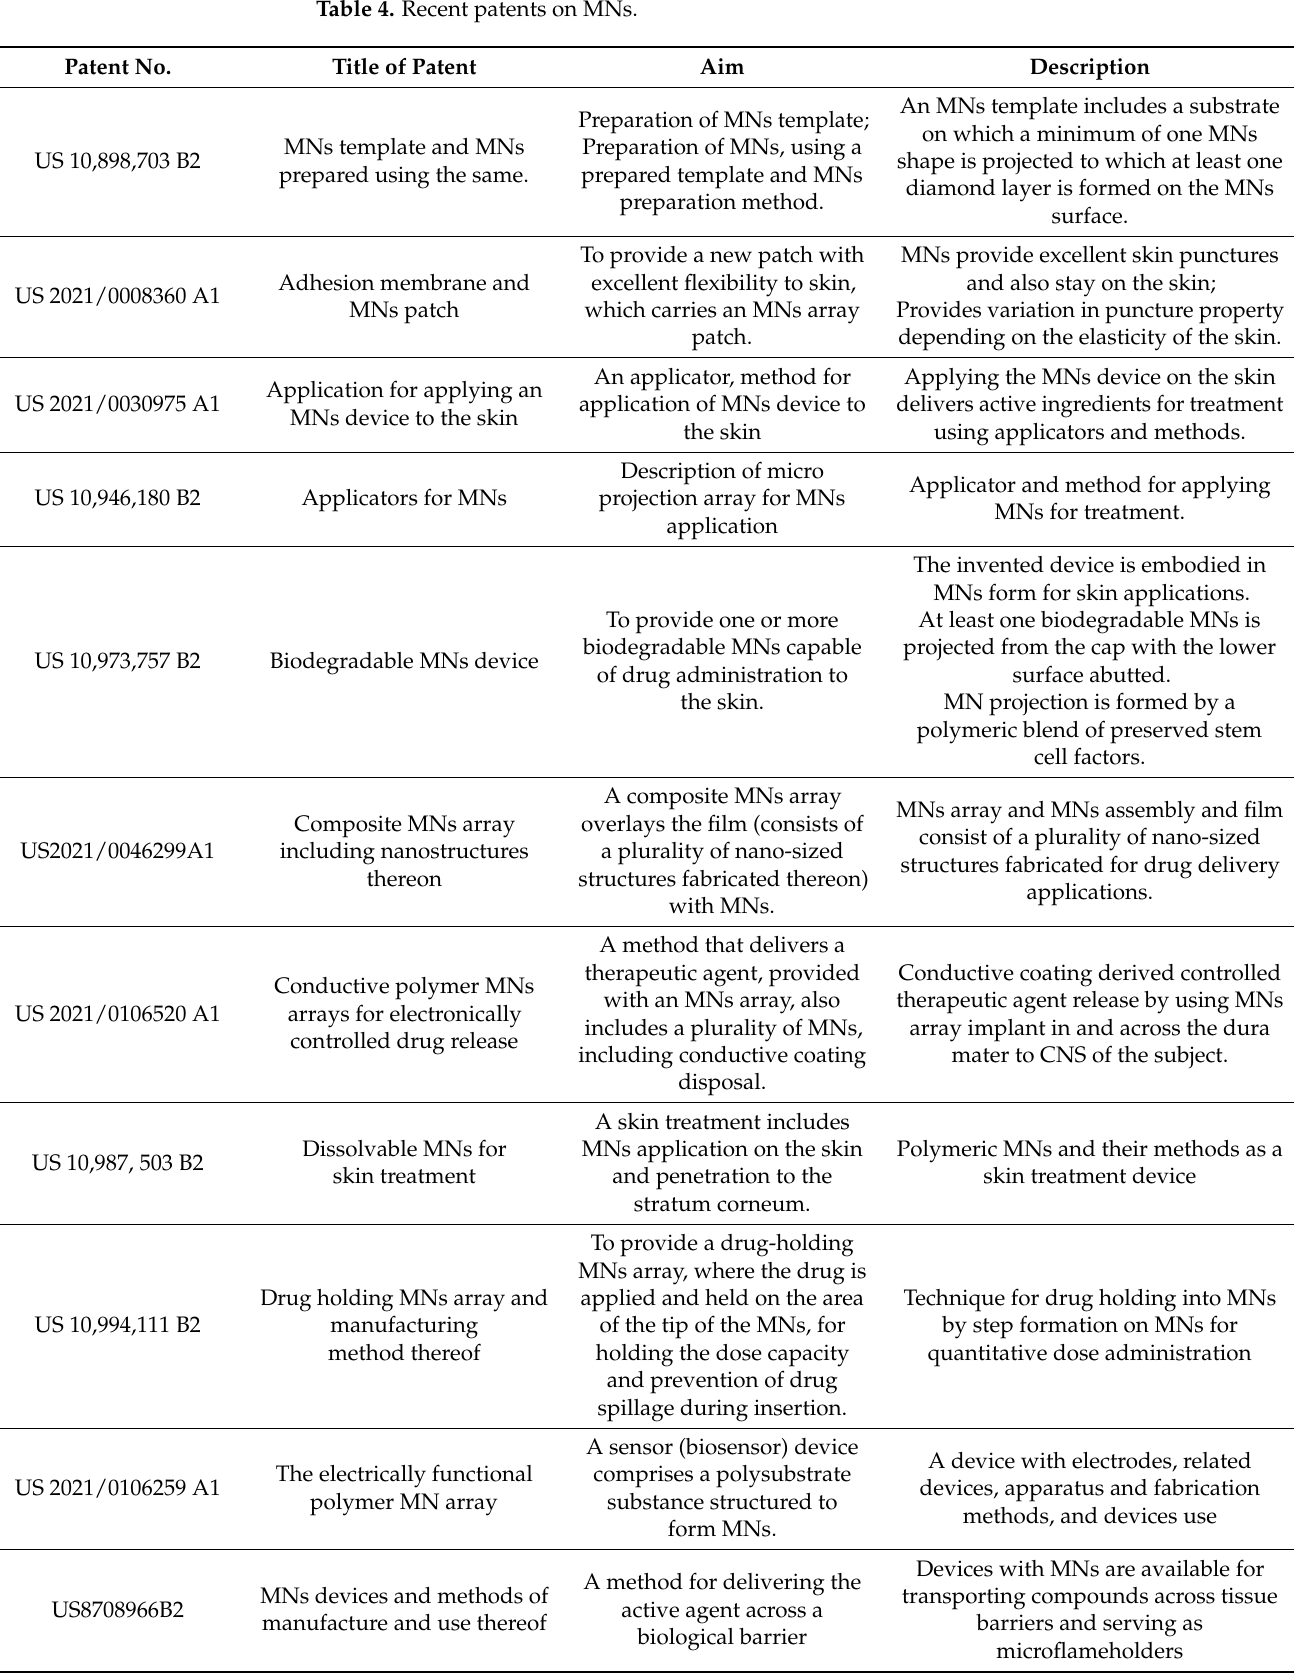
Table 4. Recent patents on